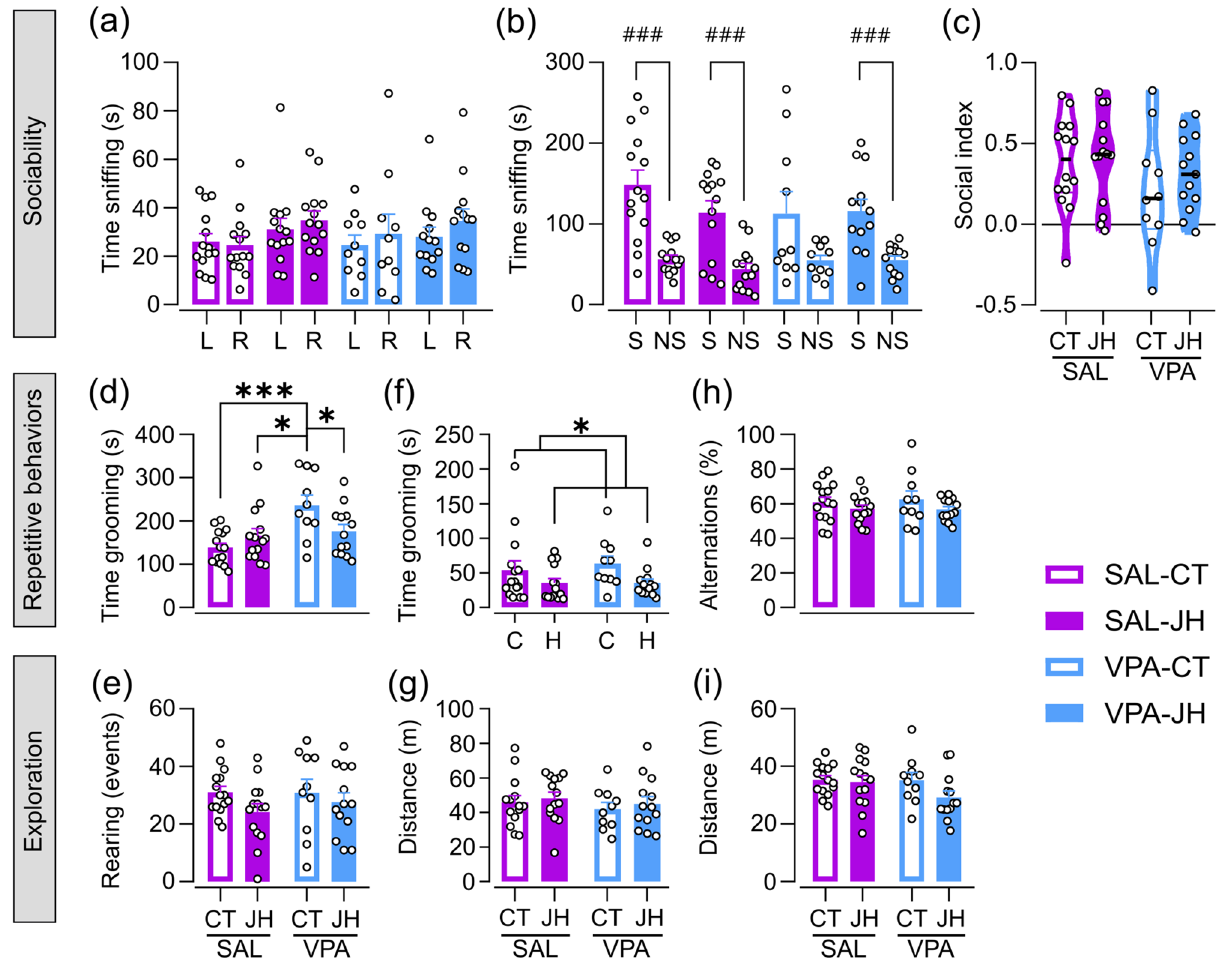
Figure 2. Effect of prenatal VPA exposure and juvenile handling (JH) on adult mice sociability, repetitive behavior, and exploration. ( a–c ) Three-chamber test: ( a ) Animals show no preference for the left (L) or the right (R) cylinder in the habituation phase. ( b ) VPA-CT animals lack the preference for the social stimulus (S) over the nonsocial cylinder (NS) observed in control groups. JH results in normalization of VPA mice sociability. Paired Student’s t test, ### p < 0.001. ( c ) VPA-CT animals show a tendency of reduced social index. ( d,e ) Self- grooming test: ( d ) VPA-CT animals spend more time in grooming than all other groups. LME model followed by Tukey’s post hoc comparisons, *p < 0.05, ***p < 0.001. ( e ) All animals perform similar rearing events. ( f,g ) Open field test: ( f ) Animals handled post-weaning spend less time grooming in the open field. GLMM model, *p < 0.05. ( g ) Mice walk a similar distance in the arena. ( h,i ) Y maze test: ( h ) No differences among groups were observed in the percentage of alternations in the Y maze. ( i ) All animals explore the Y maze similarly. Data are shown as individual values (dots) and mean + s.e.m., except for the violin plot in ( c ). N SAL-CT = 14–15, N SAL-JH = 14, N VPA-CT = 10, N VPA-JH =